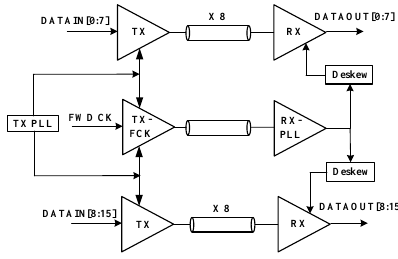
Figure 2. Forward clock